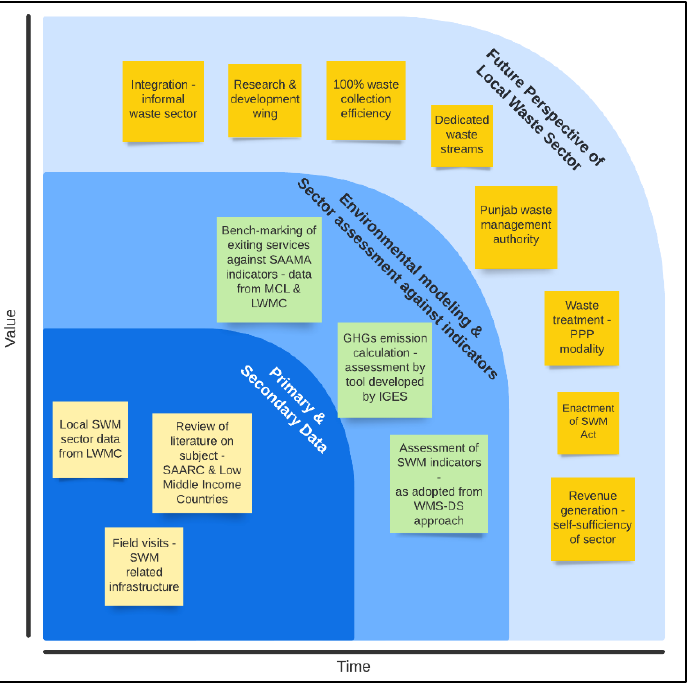
Figure 1. Scheme of methodological approach.